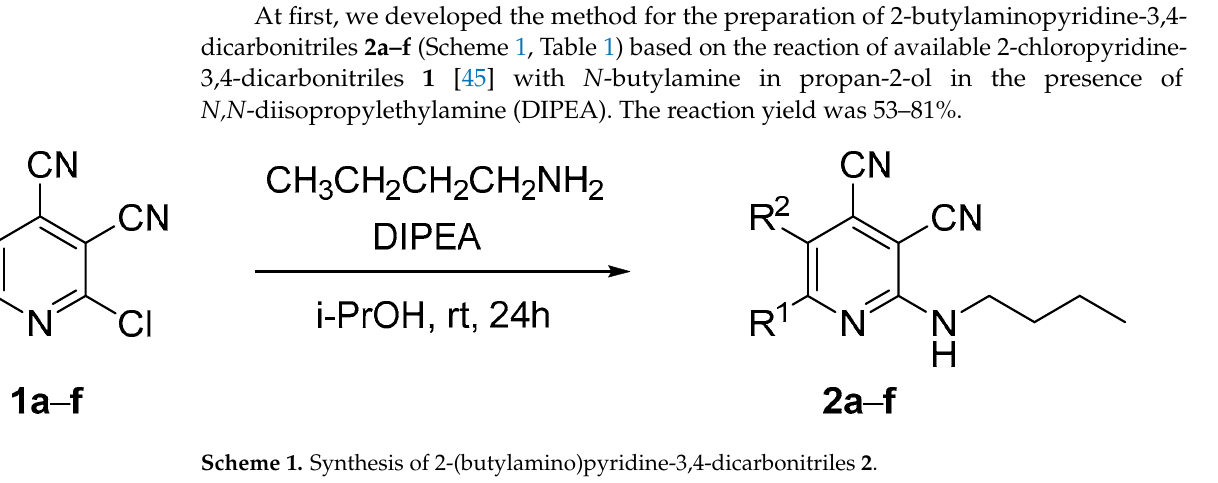
Table 1. Structure of starting compounds 1 and isolated products 2–4.